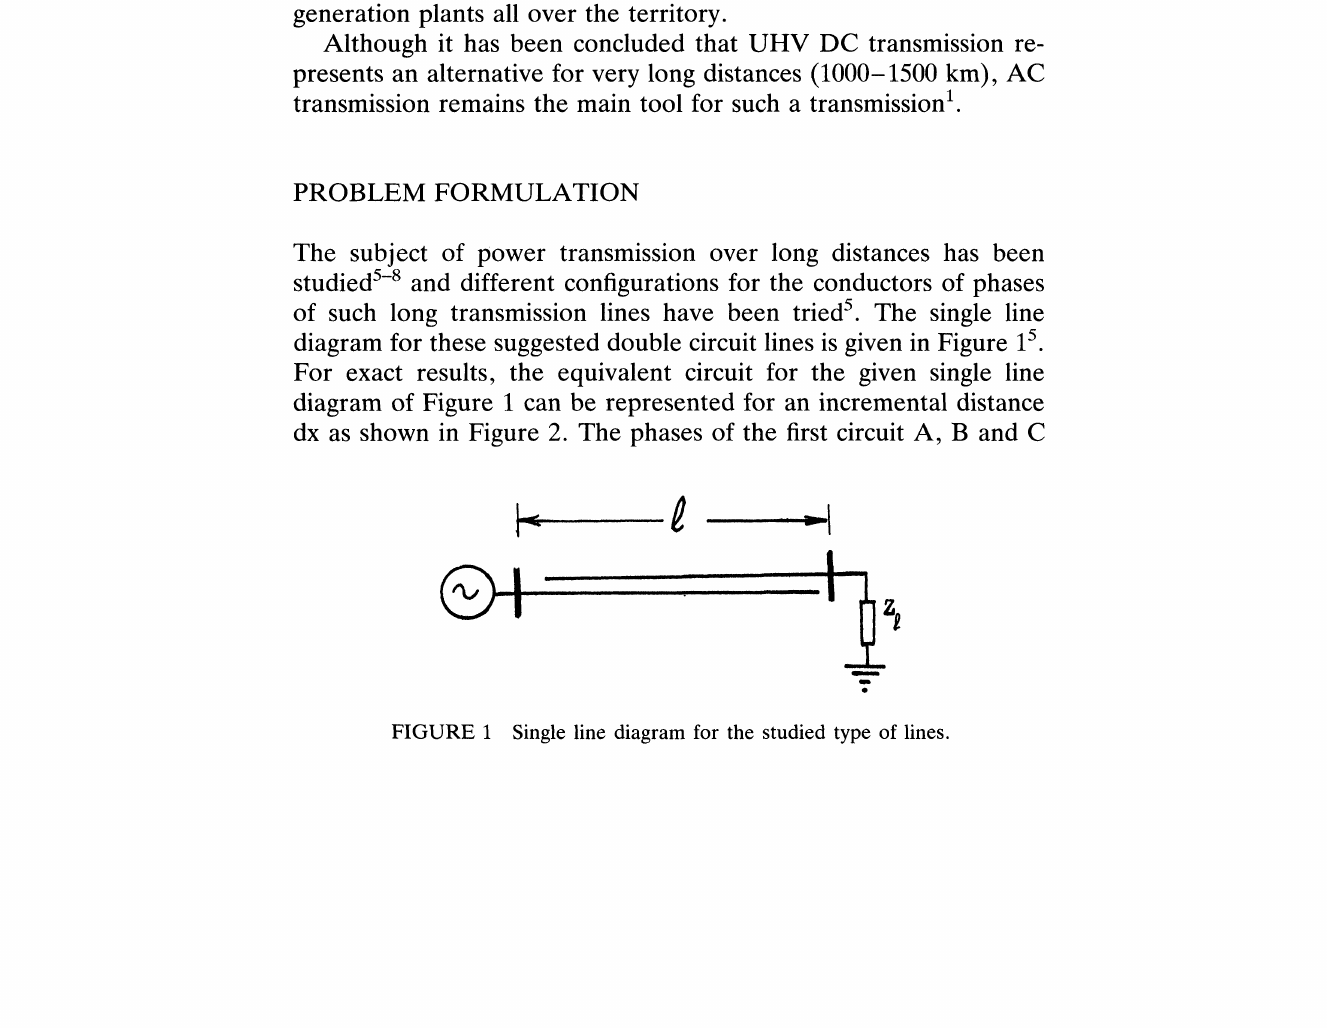
FIGURE Single line diagram for the studied type of